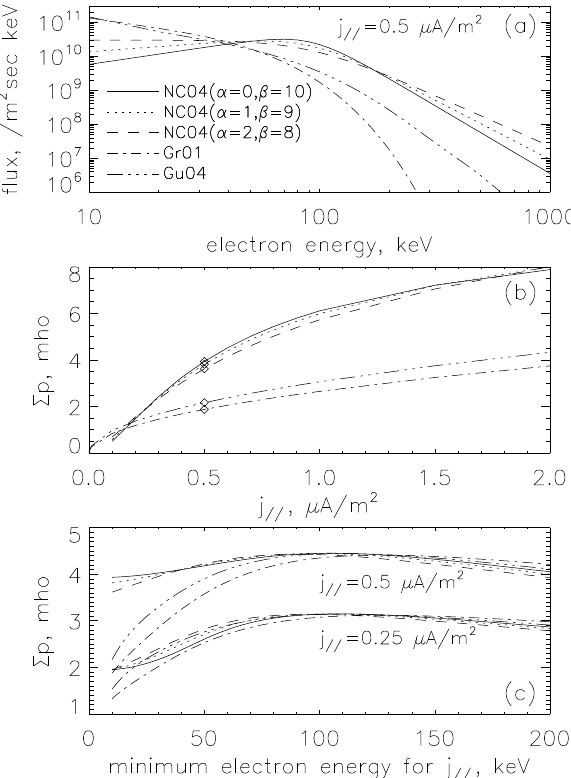
Figure 11: 2007.12.18: Y. Hiraki and C. Tao Fig. 11. (a) Assumed electron energy spectra with the current be- ing fixed as j k = 0 . 5 µ A/m 2 . NC04, Gr01, and Gu04 refer to those in Nichols and Cowley (2004), Grodent et al. (2001), and Gustin et al. (2004), respectively; α and β are control parameters of the slope of spectrum. (b) Pedersen conductance as a function of field- aligned current density obtained with each spectrum shown in (a). (c) Modified Pedersen conductance versus the base of integral en- ergy range when the current is defined. The upper and lower 5-line sets correspond to j k = 0.5 and 0.25 µ A/m 2 cases, respectively. Line types used are identical in all figures.